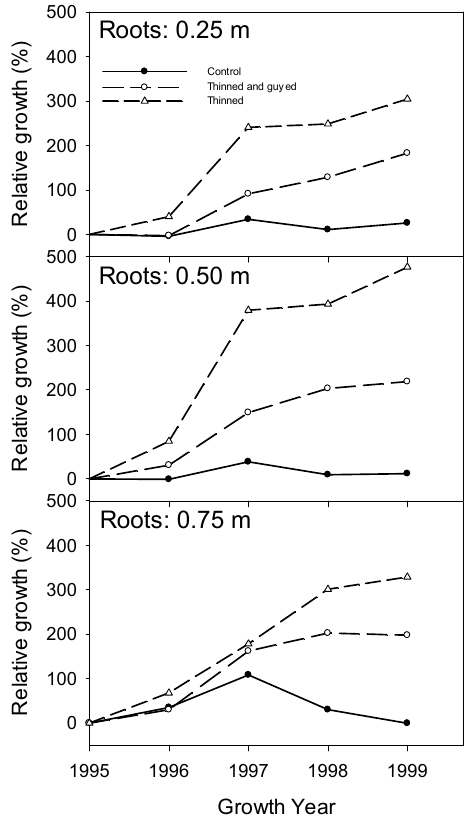
Figure 7. The relative diameter growth response following treatments, in structural roots at 0.25 m,